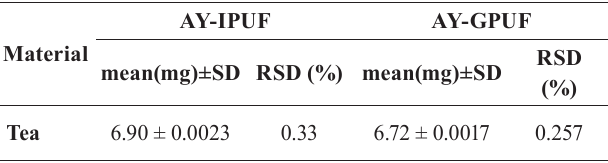
TABLE V - I solation and determination of Caffeine from tea (n=3) using imprinted and grafted foam